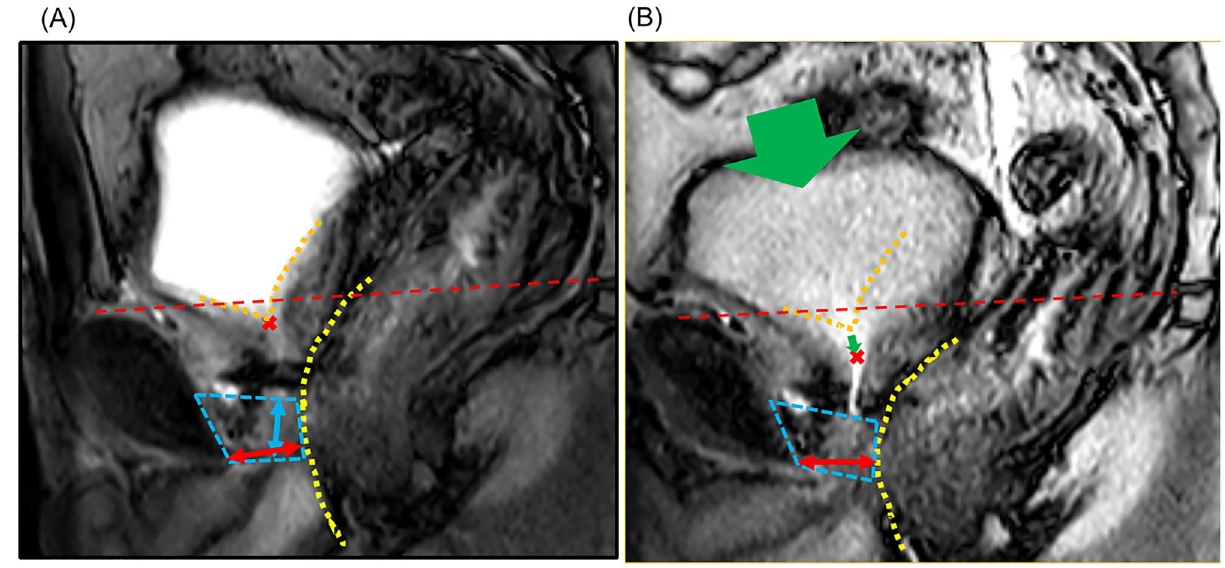
Figure 1. Dynamic mid-sagittal MRI after robot-assisted radical prostatectomy (RARP): at rest ( A ) and with abdominal pressure ( B ). The distance from the lowest point of the pubic bone to the anterior edge of the rectal wall (PB-AR, two-headed red arrow) was measured at rest and with abdominal pressure (large green arrow). The external urethral sphincter is indicated by the box surrounded by the blue dashed line. The anterior edge of the rectal wall is indicated by a yellow dashed line. The bladder base at rest is indicated by an orange dashed line. Each red cross is each urethrovesical junction (UVJ) at rest ( A ) and with abdominal pressure ( B ). The UVJ is positioned using the line that connects the superior border of the pubic bone and the lower sacrum (red dashed line) as an index. The small green arrow indicates UVJ